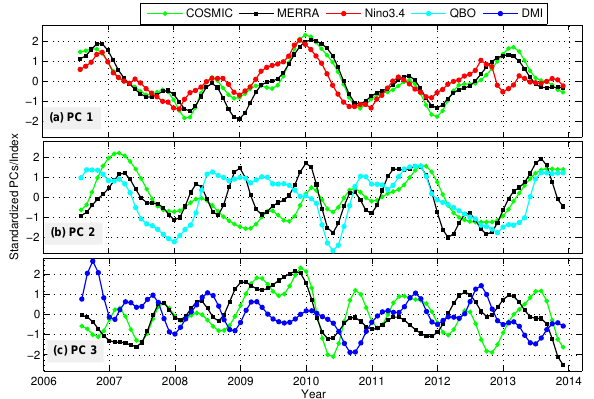
Figure 12. The corresponding PCs (temporal components) based on the three leading orthogonal modes shown in Fig.